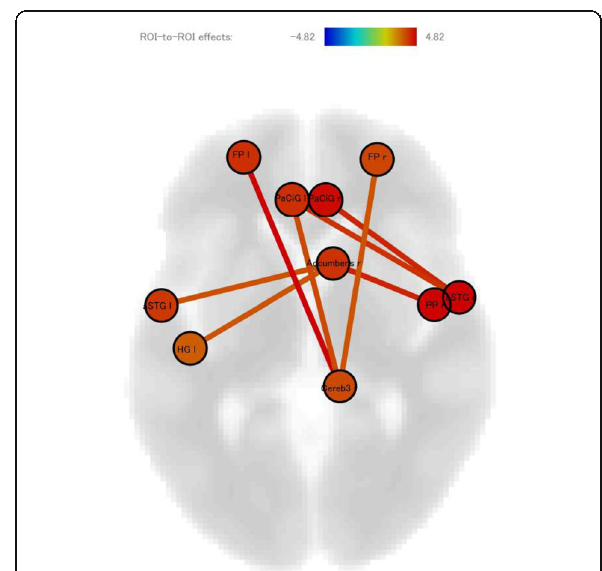
Fig. 2 (abstract P66). See text for